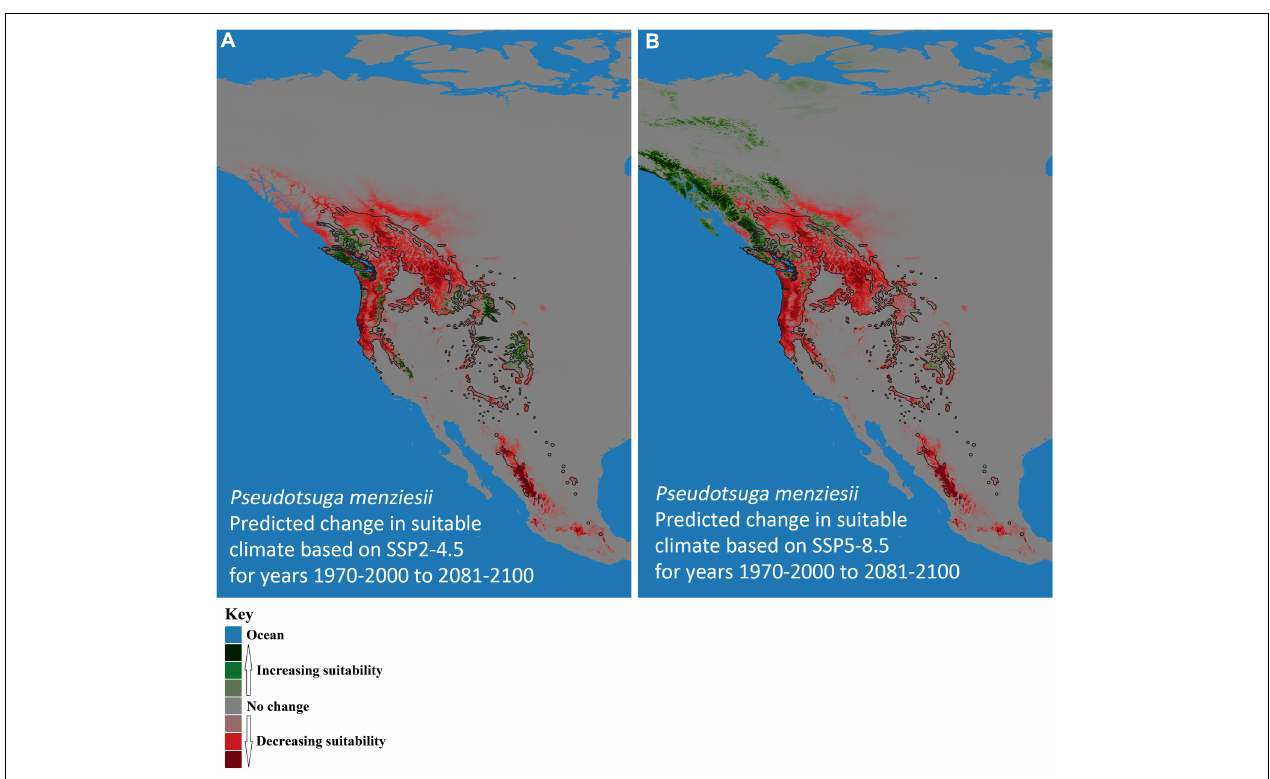
FIGURE 4 | Predicted change in climate suitability for Pseudotsuga menziesii (Douglas-fir) in western North America from contemporary (1970–2000) to future (2081–2100) models. (A) Shared Socioeconomic Pathway (SSP) SSP2-4.5 and (B) SSP5-8.5. Pink to dark red, respectively, indicates increasing probability of disappearing climate suitability (i.e., ecophysiologically maladapted trees), while light green to dark green, respectively, represents predictions of new climatically suitable areas. The black outline designates Little’s (1971) P . menziesii range